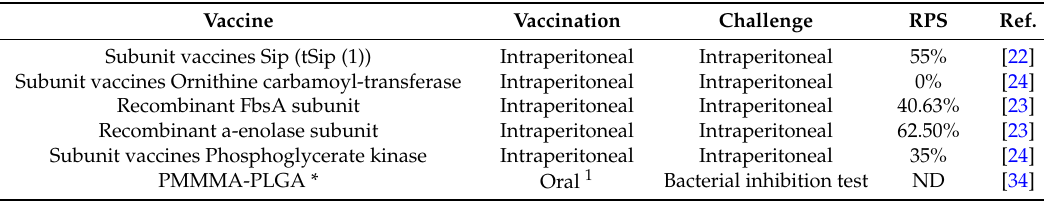
Table 4. Subunit vaccines showing delivery systems and modalities of vaccination. Vaccine